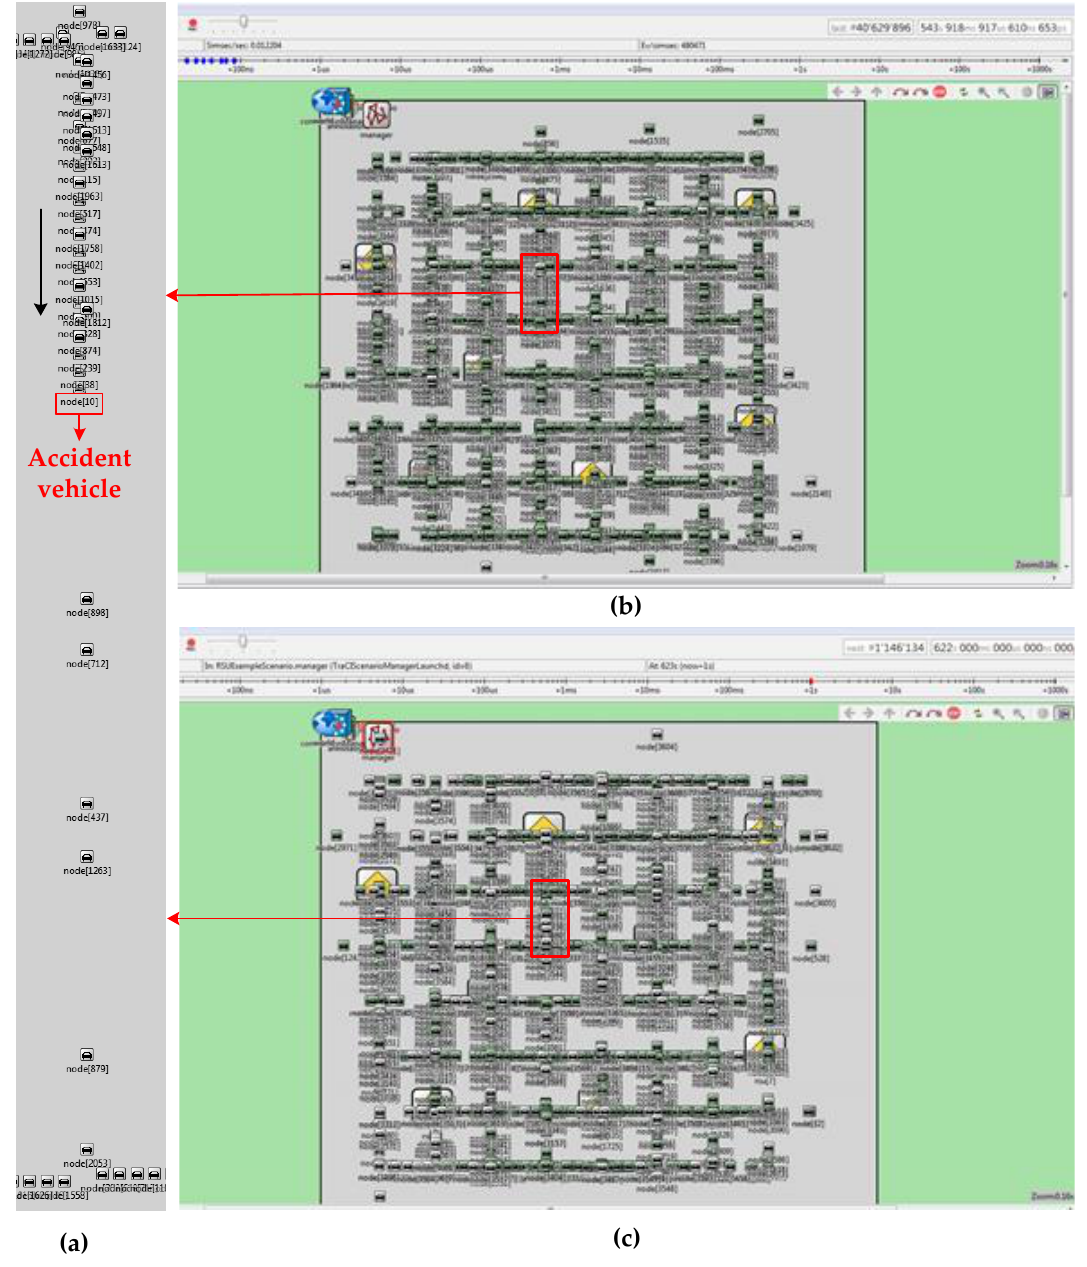
Figure 21. Running interface of the simulation: ( a ) the accident vehicle on lane E6E5; ( b ) almost all vehicles have received the message in the connected RSUs scenario; ( c ) most vehicles have received the message in the disconnected RSUs scenario.